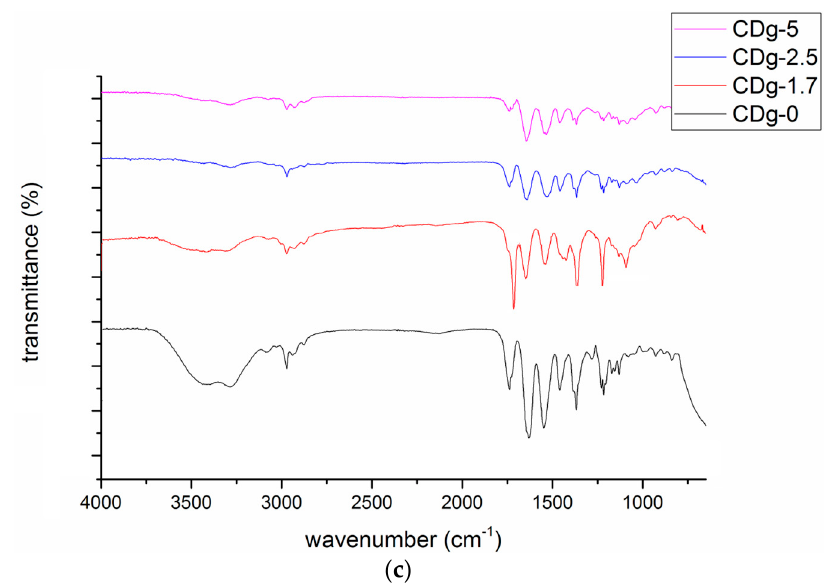
Figure 5. FTIR Spectra of: ( a ) NIPAM, IAM and unmodified β -CD monomers; ( b ) poly(CD-NIPAM-IAM) copolymers; and ( c ) poly(CD-NIPAM-IAM) hydrogels.